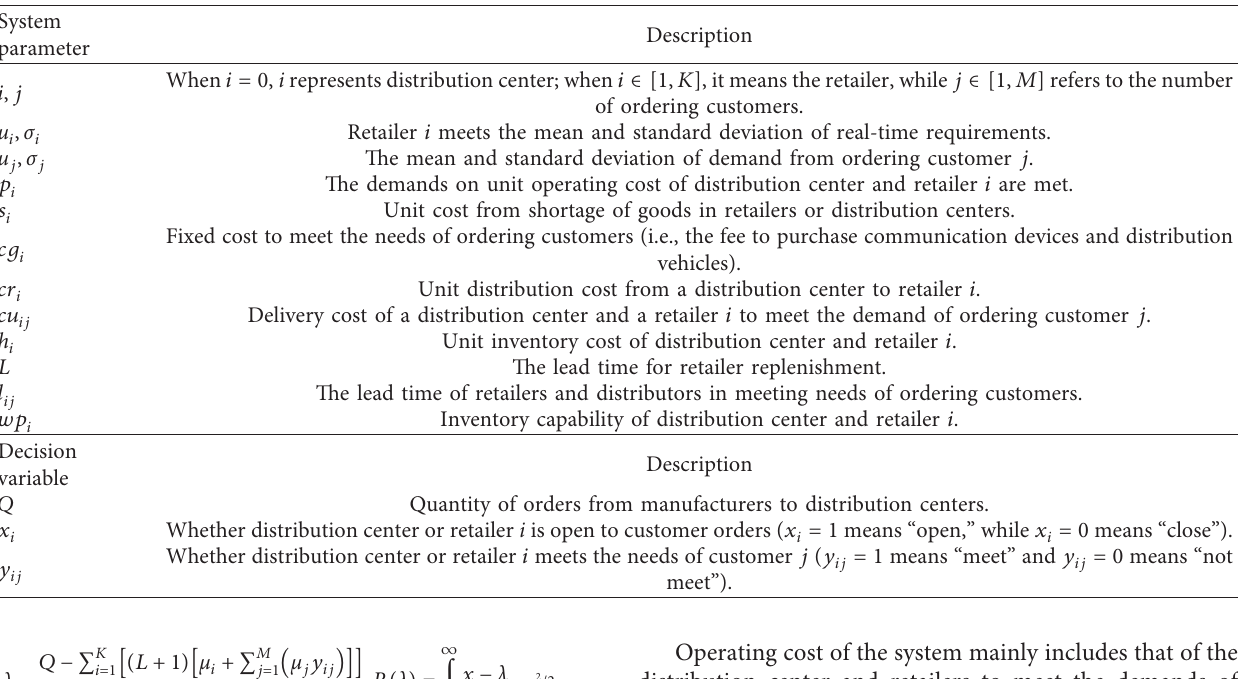
Table 1: Description of symbols applied in the biobjective distribution network